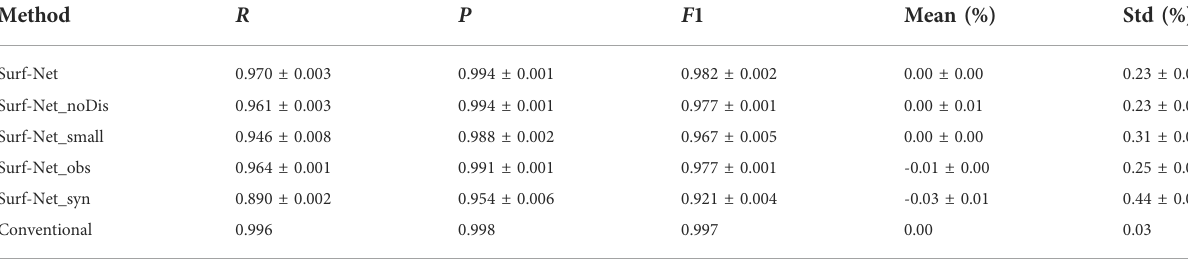
TABLE 2 Performance for single picks in the observational test set. The threshold is set to 1.5%.